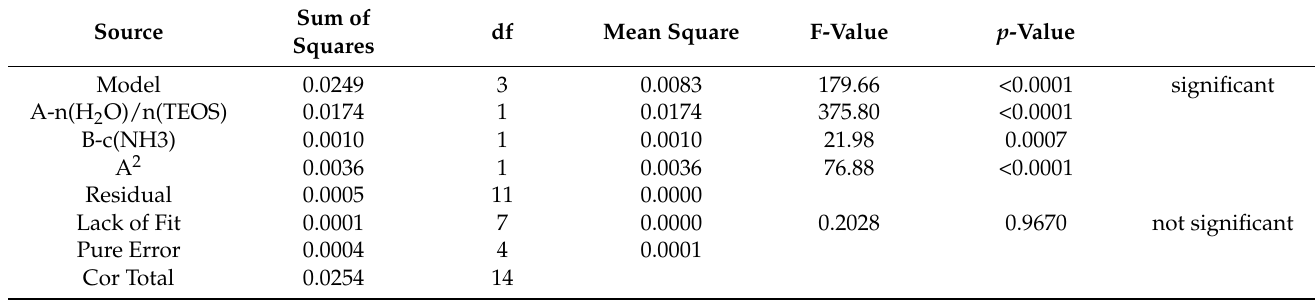
Table A5. Analysis of variance (ANOVA) for the analysis of the FCD design of the V p .